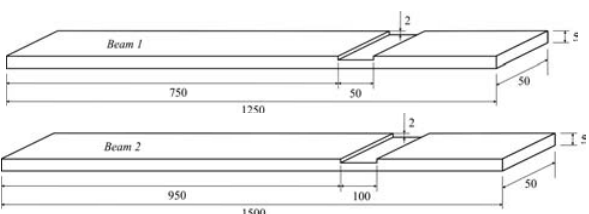
Fig 1. Geometry and dimensions of the test beams containing mill-cut damage at single location